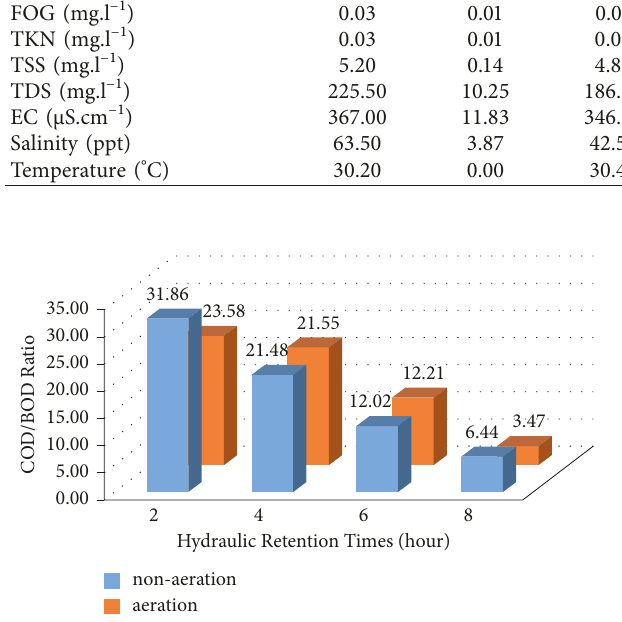
Figure 3: COD and BOD ratio of aeration and nonaeration HSFCWs